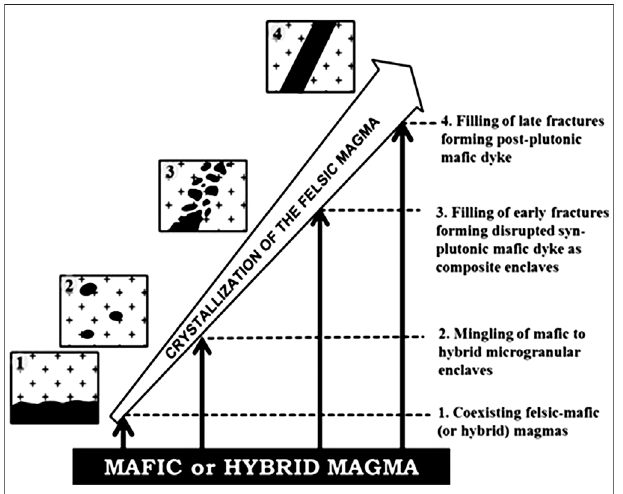
FIGURE 10 | Schematic presentation of ma fi c to hybrid magma injections into the progressively crystallizing felsic magma chamber and the resultant geometry of enclaves (after Barbarin, 1989; Barbarin and Didier, 1992, with the addition of “ hybrid ” by Kumar, 2014).